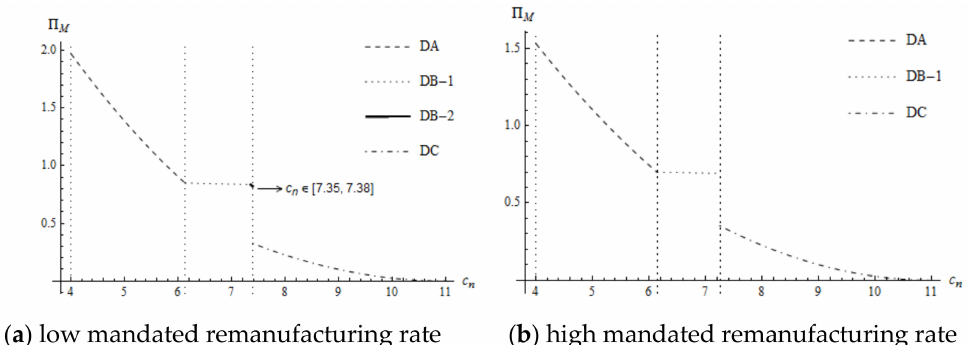
Figure 5. The impact of c n on the manufacturer’s